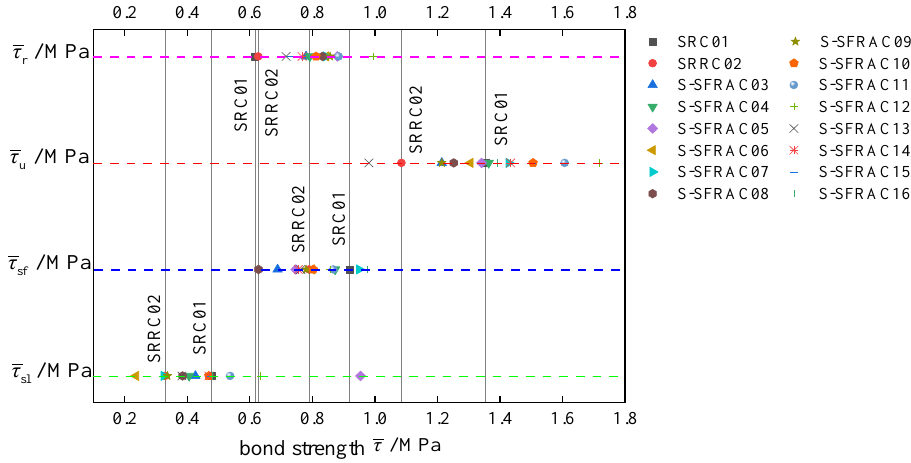
Figure 15. Distribution diagram showing the characteristic bond strengths of each specimen.